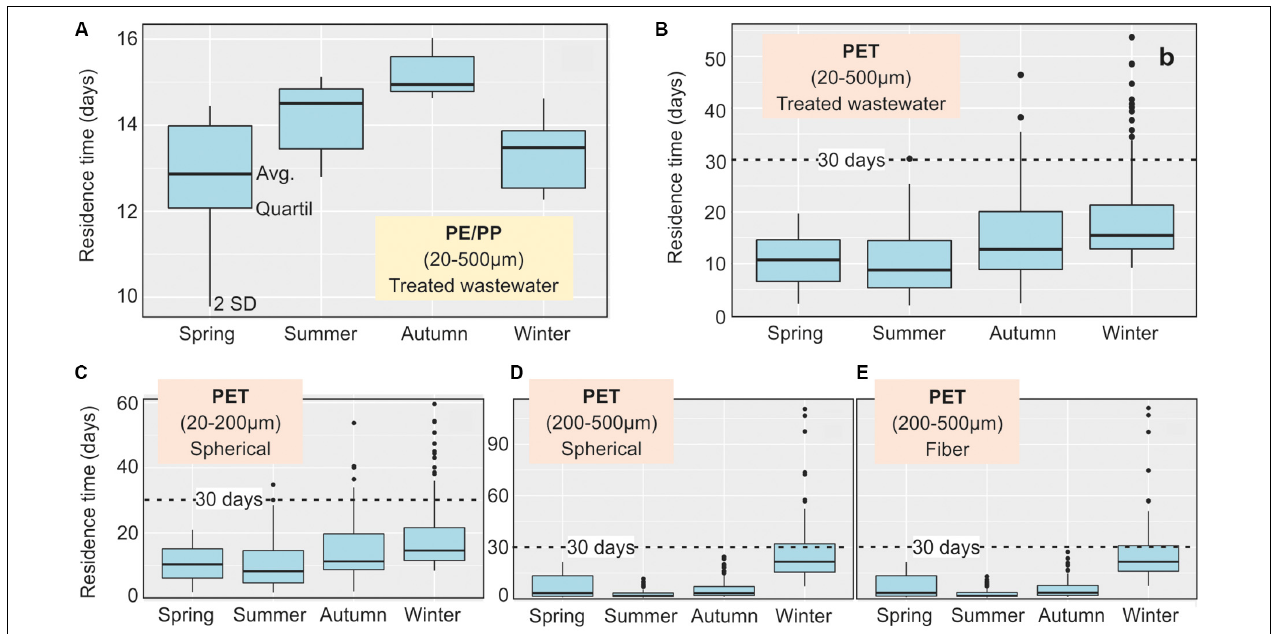
FIGURE 3 | Residence time of Polyethylene (PE)/Polypropylene (PP) and Polyethylenterephthalat (PET) microplastic particles in the Baltic Sea in different meteorological seasons. The results are based on simulations with a 3D hydrodynamic model using meteorological data of the years 2016/2017. PE/PP represents floating and PET sinking plastic. The emissions cover all three urban sources. (A,B) cover the 20–500 µ m size fraction; (C) focusses on the small 20–200 µ m fraction and (D,E) address the larger fraction (200–500 µ m), but separate between spherical and fiber shaped particles. The Box-Plots indicate the median, the upper and lower quartile and 2 ∗ standard deviation as well as extreme values.